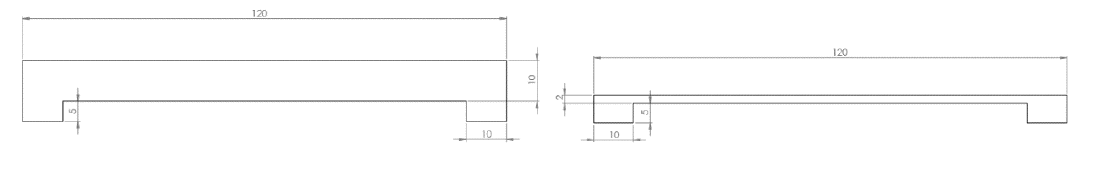
Figure 1. Flexible face major dimensions. The faces ranges from 10 to 2 mm thick in 2 mm intervals.